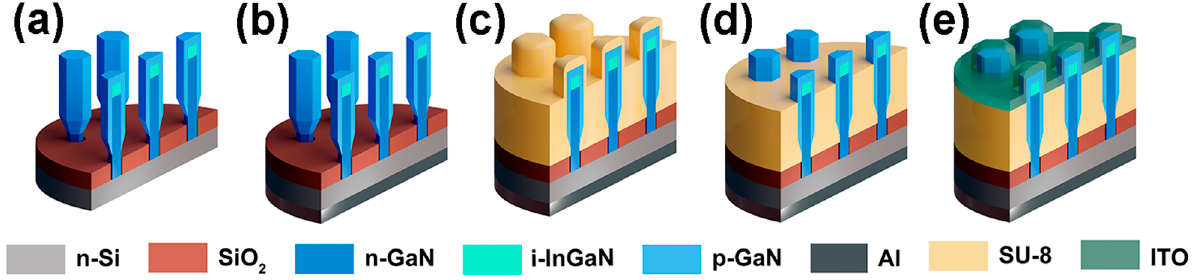
Figure 4. Workflow of NWs-based LEDs processing: ( a ) HF treatment, ( b ) evaporation of Al back contact, ( c ) covering with SU-8, ( d ) opening of NWs ends, ( e ) ITO sputtering.